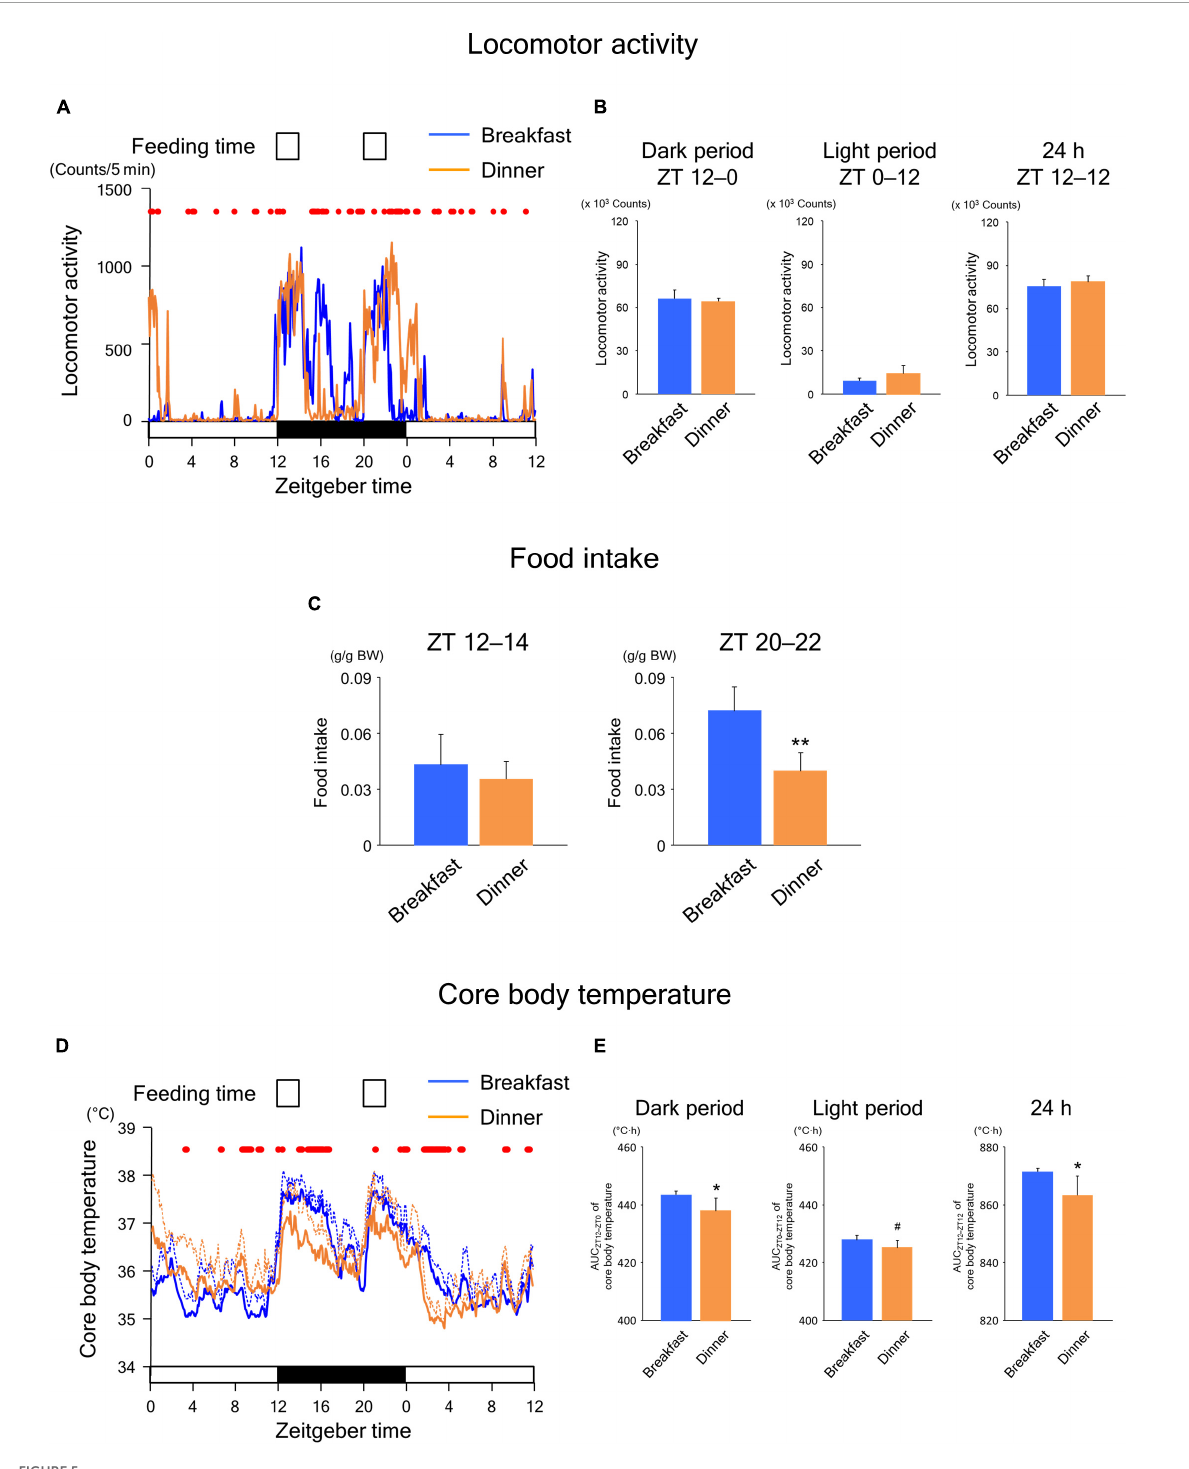
FIGURE5 Sustained effects of time-restricted feeding on locomotor activity (A,B) , food intake (C) , and CBT (D,E) on days 18–19 in UCP1 KO mice. (A) Daily profiles of locomotor activity. Data are medians of four mice. Red dots indicate P < 0.05 between the groups at each time point. (B) Amounts of locomotor activity during the dark period on day 18, light period on day 19, and the total 24-h period. Data are means + SD of four mice. (C) Food intake. Data are means + SD of four mice. ** P < 0.01. (D) Daily profiles of CBT. Solid and dotted lines indicate means and means + SD, respectively, of four mice. Red dots indicate P < 0.05 between the groups at each time point. (E) AUC of CBT during the dark period on day 18, light period on day 19, and the total 24-h period. Data are means + SD of four mice. # P < 0.1, * P <